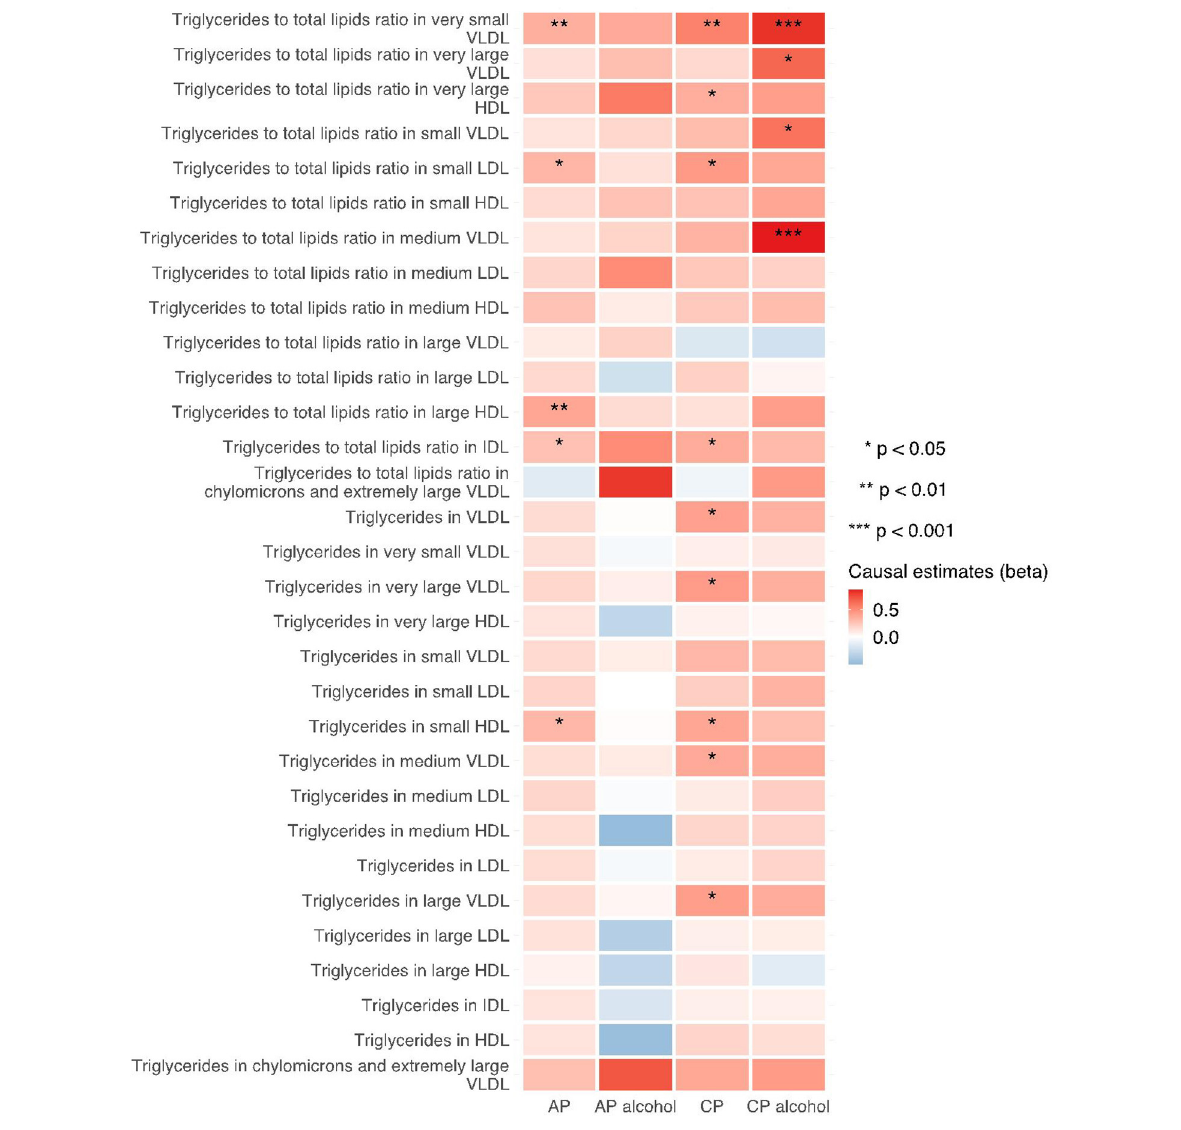
FIGURE3 Heatmap showing the weighted median causal estimates of triglycerides related traits in met-d on pancreatitis using two-sample MR. AP, acute pancreatitis; CP, chronic pancreatitis; IVW, inverse-variance weighted; VLDL, very-low-density lipoprotein; LDL, low-density lipoprotein; IDL, intermediate-density lipoprotein; HDL, high-density